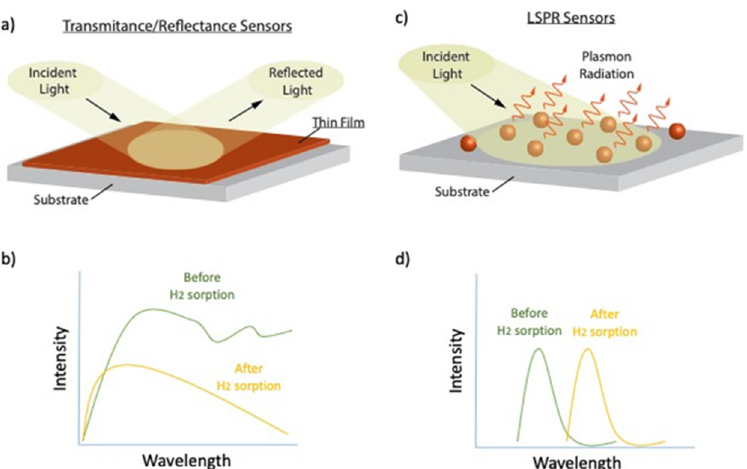
Figure 1. ( a ) Illustration of a thin film structure for reflection (or transmission) H 2 sensing. ( b ) Graph showing the changes in the optical properties (reflection/transmission) of a thin film-based sensors, upon H 2 sorption. ( c ) Illustration showing the operating principle of the plasmonic H 2 sensors composed of isolated nanoparticles. ( d ) Changes in the LSPR radiation spectrum (i.e., peak position and amplitude) for a plasmonic H 2 sensor comprised of isolated nanoparticles.